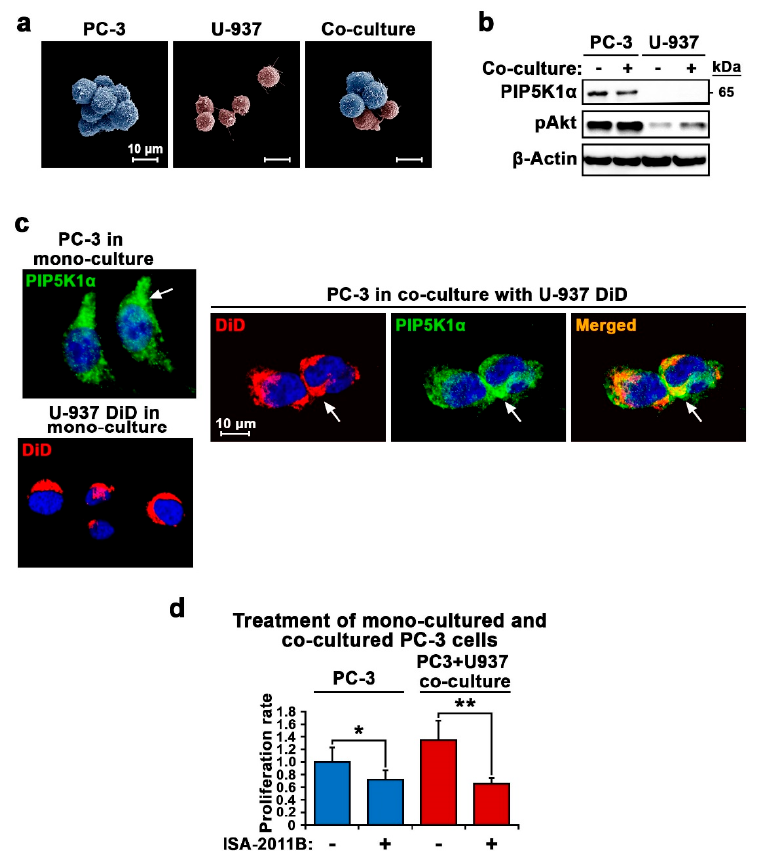
Figure 5. Interaction between PC-3 cells and bone marrow cells is linked to PIP5K1 α -associated pathways. ( a ) Transmission electron microscopy images of U-937 cells (pink) and PC-3 cells (blue) in mono-culture or co-cultured in suspension culture conditions are shown. ( b ) Immunoblot analysis of PIP5K1 α /phosphorylated AKT (pAKT) expression in PC-3 and U-937 cells in mono- ( − ) or in co-culture (+) is shown. ( c ) Representative immunofluorescent images showing the 1,1 ′ -dioctadecyl- 3,3,3 ′ ,3 ′ -tetramethylindodicarbocyanine perchlorate (DiD)-membrane stained U-937 cells from mono-culture and mono-cultured PC-3 cells stained with fluorescein (FITC)-conjugated PIP5K1 α antibody (left panel). U-937 cells were stained with DiD and were co-cultured with PC-3 cells. PC-3 cells were collected and were stained with FITC-conjugated PIP5K1 α antibody. In the right panel, representative images show that PC-3 cells collected from the co-culture show DiD staining in red and PIP5K1 α -antibody staining in green. Merged image shows the overlap of red and green in orange color. ( d ) The effect of inhibition of PIP5K1 α by its kinase inhibitor ISA-2011B on PC-3 cell proliferation in mono-culture and in co-culture with U-937 cells is shown. Mono- or co-cultured PC-3 cells were treated with DMSO as control or ISA-2011B at 25 µ M for 48 h. For mono-cultured control-treated vs. ISA-2011B-treated PC-3 cells, p = 0.031. For co-cultured control-treated vs. ISA-2011B-treated cells, p < 0.001. Data means are from three independent experiments. ** p < 0.01 and * p < 0.05 are